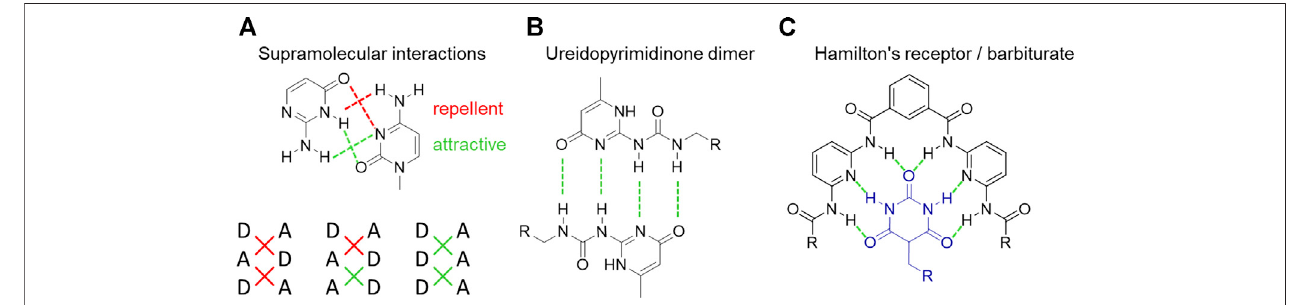
FIGURE 4 | Triple hydrogen bonds bearing different donor (D) and acceptor (A) [side arrangements display different association strengths (A) , the ureidopyrimidinone group with an AADD bonding scheme (B) , and a very strong hydrogen-based interaction between Hamilton ’ s receptor and the barbiturate group (C)